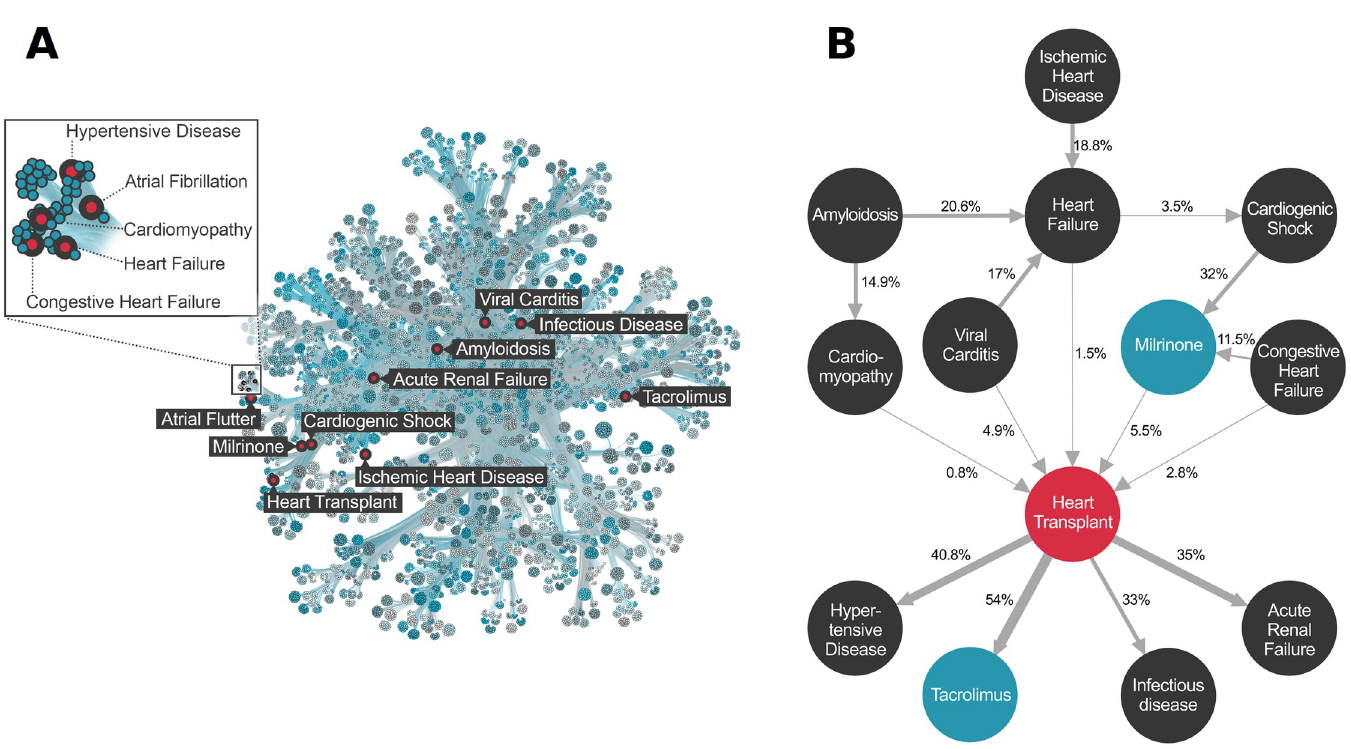
Fig 2. Patient Disease Network for the Utah Data Resource. Panel A. Graphical representation of the Patient Disease Network. 39,055 ICD 10 diagnosis codes, 5,716 CPT procedure codes, and 1,764 RxNorm medication codes comprising 50 million comorbidities are represented by the map. To render the patient disease network more readily interpretable, we utilized Minimum Description Length clustering, so that nodes with similar comorbidity patterns lay near to one another in the network. The comorbidities of Heart Transplant are labeled red for reference purposes. See Methods for details. Panel B. Term trajectory for Adult Heart Transplant. Nodes represent diagnosis (black), procedures (red), and medications (blue). Edges are temporally ordered comorbidities (Bonferroni alpha = 10E-9.5), arrows denote direction. Edges are labeled with transition probabilities (e.g. patient flux). For example, an adult patient with viral myocarditis has a 17% chance of developing a heart failure diagnosis, and a 4.9% chance of undergoing heart transplantation. See Methods for additional details and S5 Table for code references for the highlighted terms.